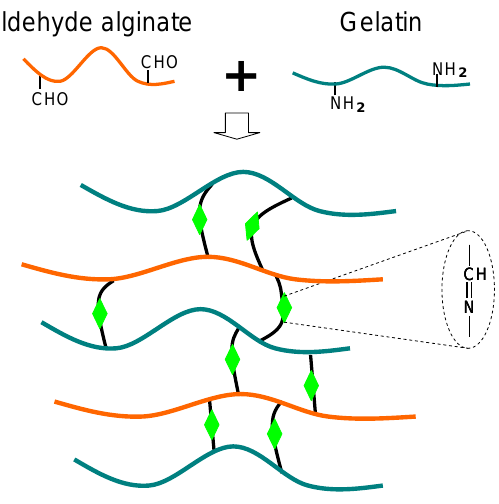
Figure 5. Scheme of alginate-gelatin composite hydrogel via the Schiff-base